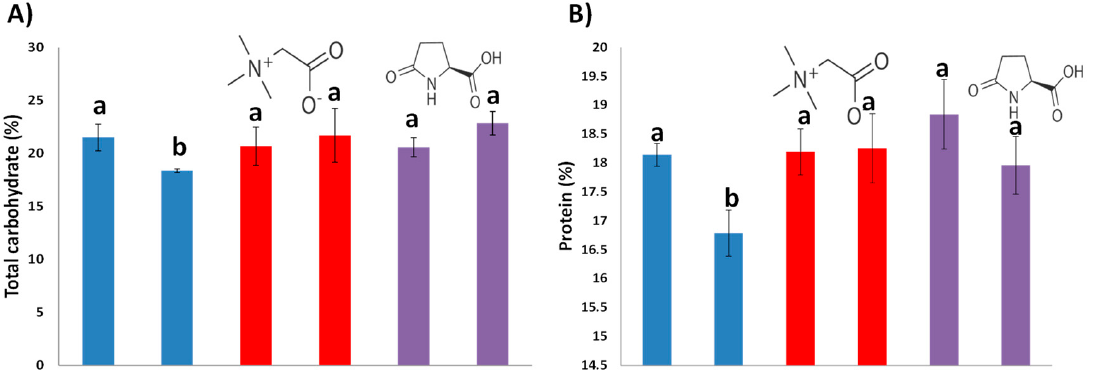
Figure 4. Carbohydrate and protein determination. Red and violet correspond to GB and PG